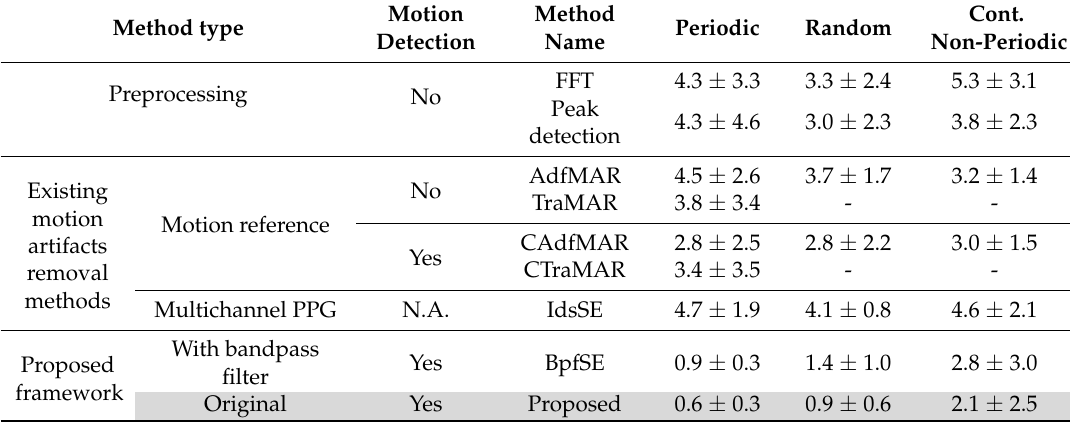
FFT: peak detection using FFT after preprocessing, Peak detection: time-domain peak detection after preprocessing, AdFMAR: Adaptive Filtering based MAR [24], CAdFMAR: Adaptive Filtering based MAR [24] with motion detection, TraMAR: Track motion frequency-based MAR [22], CTraMAR: Track motion frequency-based MAR [22] with motion detection. IdsSE: Direct signal decomposition with independent component analysis (ICA),